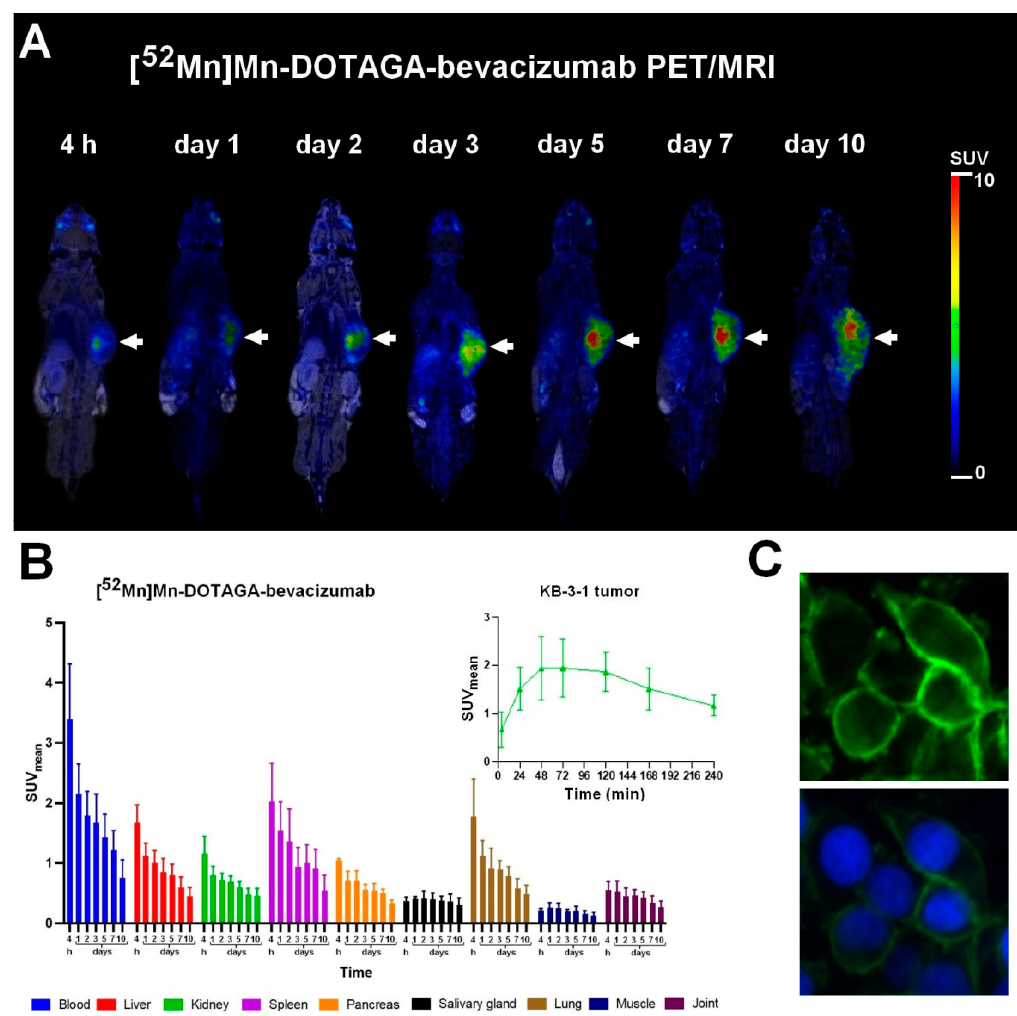
Figure 5. In vivo PET/MRI imaging of KB-3-1 cervix carcinoma tumor-bearing mice ( A ). Representa- tive decay-corrected coronal PET/MRI images were obtained from 4 h to 10 days post injection of [ 52 Mn]Mn-DOTAGA-bevacizumab. White arrows: subcutaneously growing KB-3-1 cervix tumors. ( B ) The panel shows the biodistribution and the average time-activity curve (TAC) for the VEGF-A positive KB-3-1 tumors 4 h, 1, 2, 3, 5, 7, and 10 days after the intravenous injection of approximately 10 MBq of [ 52 Mn]Mn-DOTAGA-bevacizumab. SUV: standardized uptake value. Data are presented as mean ± SD and obtained from n = 5 animals/time point. ( C ) panel demonstrates the VEGF-A positivity of subcutaneously growing KB-3-1 tumor by immunohistochemical study. Upper image: VEGF-A receptors (green color by Alexa-488 staining); lower image: VEGF-A receptors and nuclear counterstaining (blue color by DAPI staining).